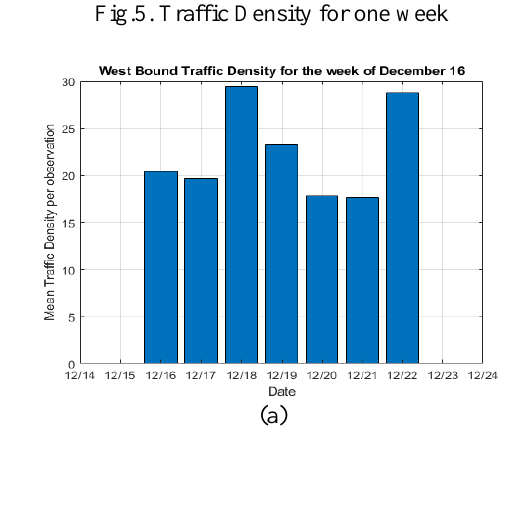
Fig.5. Traffic Density for one week